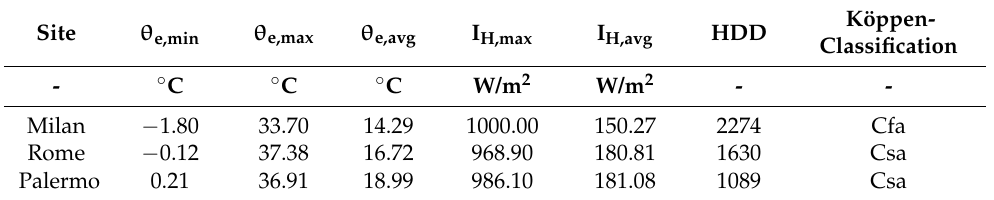
Table 6. Outdoor temperature (min, max and average), horizontal solar radiation (max and average) and heating degree days of the three considered